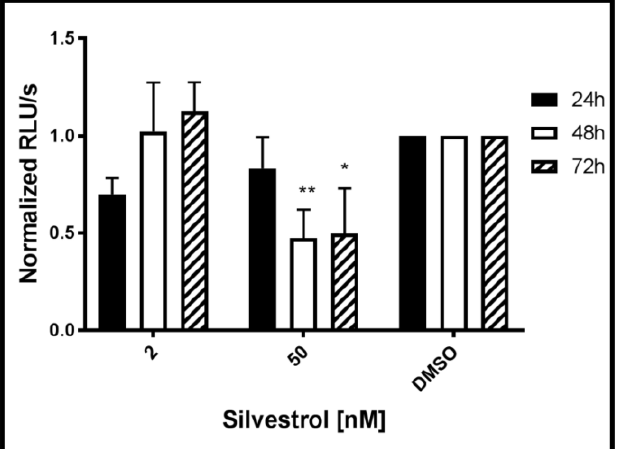
Figure 6. Effect of silvestrol on the genome replication of HEV genotype 3 strain p6Kernow Gaussia luciferase reporter constructs in A549 cells. Intracellular luciferase activity measured in RLU/s normalized to total protein amount after silvestrol treatment (2 and 50 nM) compared to the DMSO-treated cells. n = 3 for all experiments; * p < 0.05, ** p < 0.01.